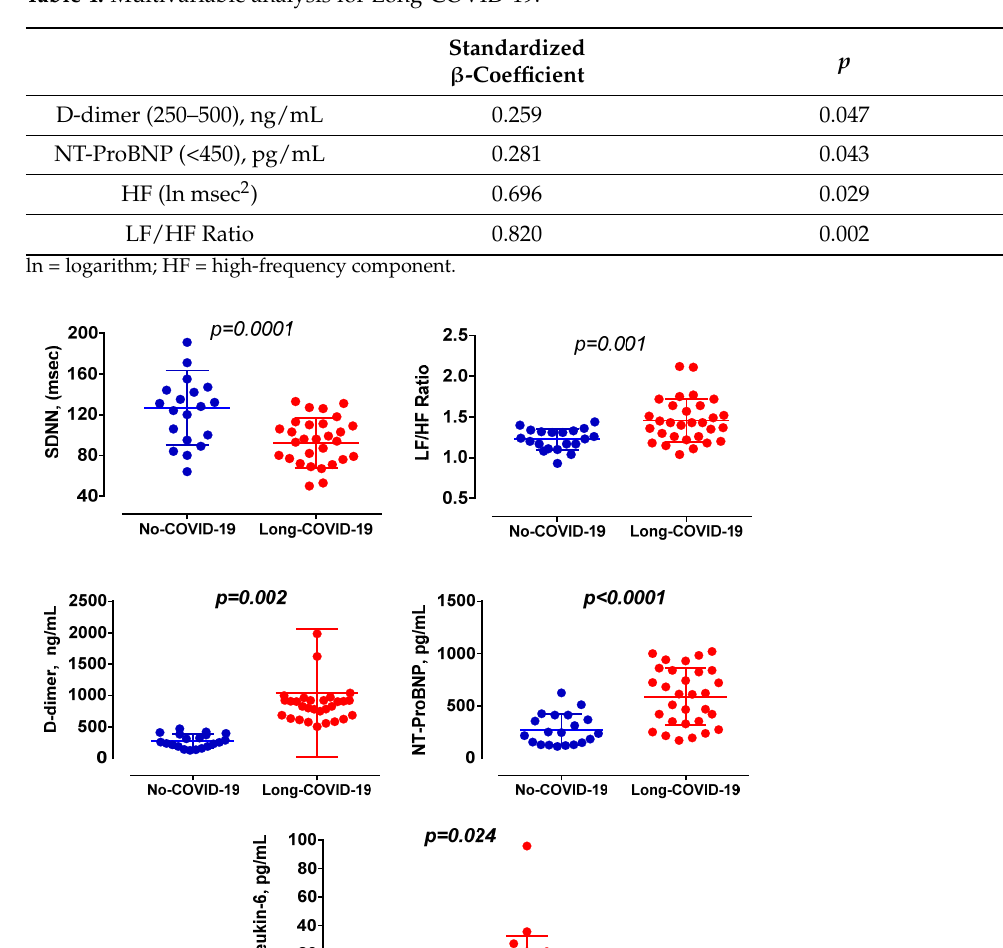
Table 4. Multivariable analysis for Long-COVID-19.